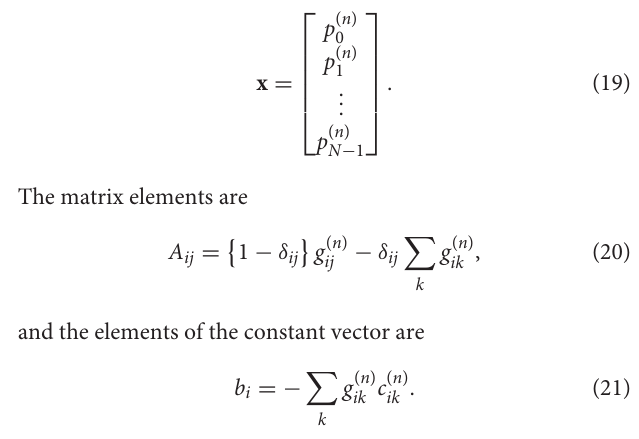
quantities evaluated at the discrete times are denoted with time step superscripts,